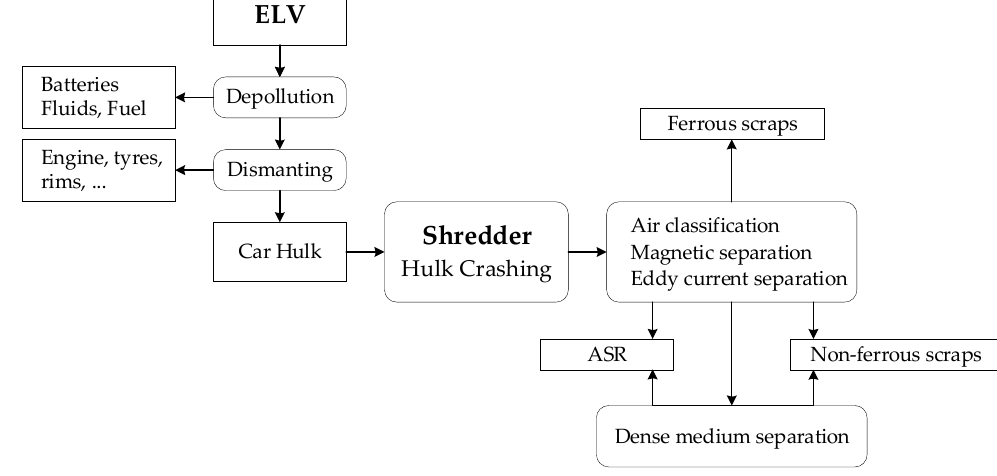
Figure 2. Recycling process of ELVs.